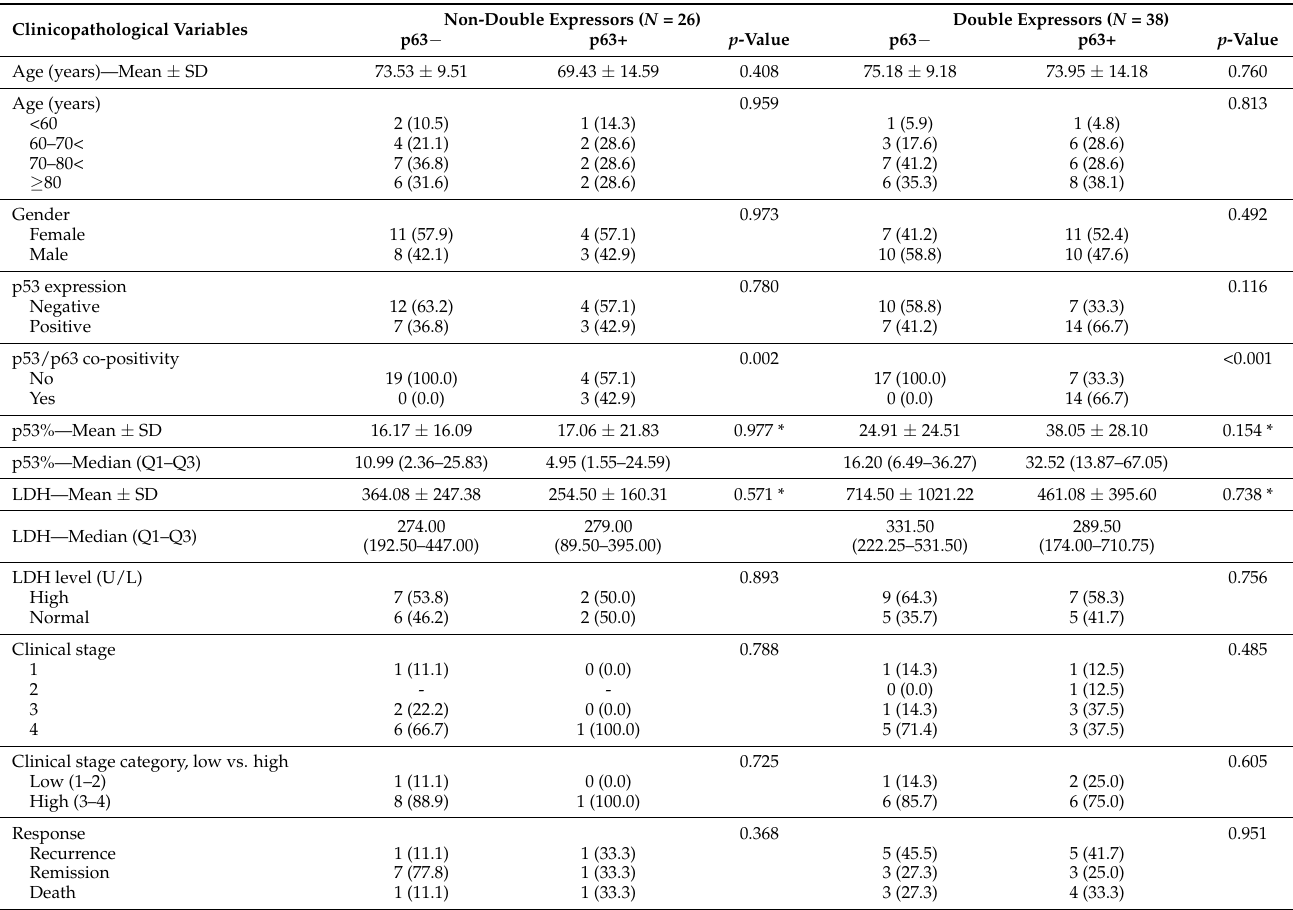
Table 3. Correlation between p63 positivity and clinicopathological characteristics of patients strati- fied into non-double expressors and double expressors ( N =